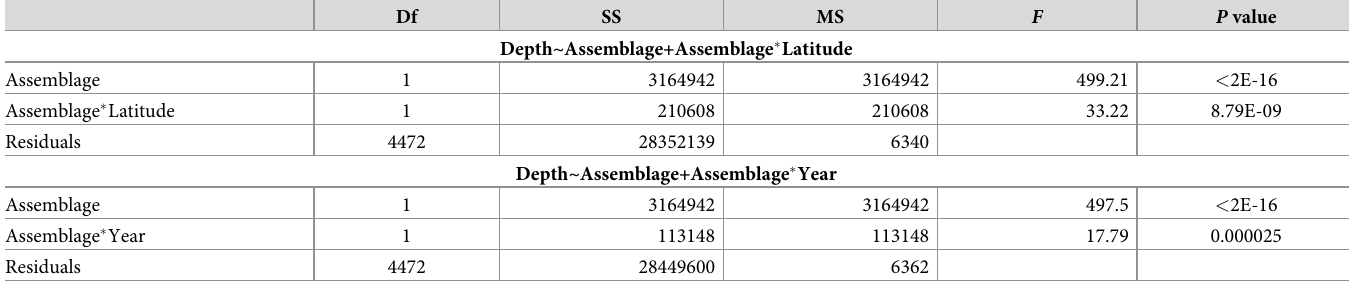
Table 3. Nested Analysis of Variance (ANOVA) of depth distribution of assemblages identified by multivariate analyses and defined in Table 3, compared by lati- tude and year. Df SS